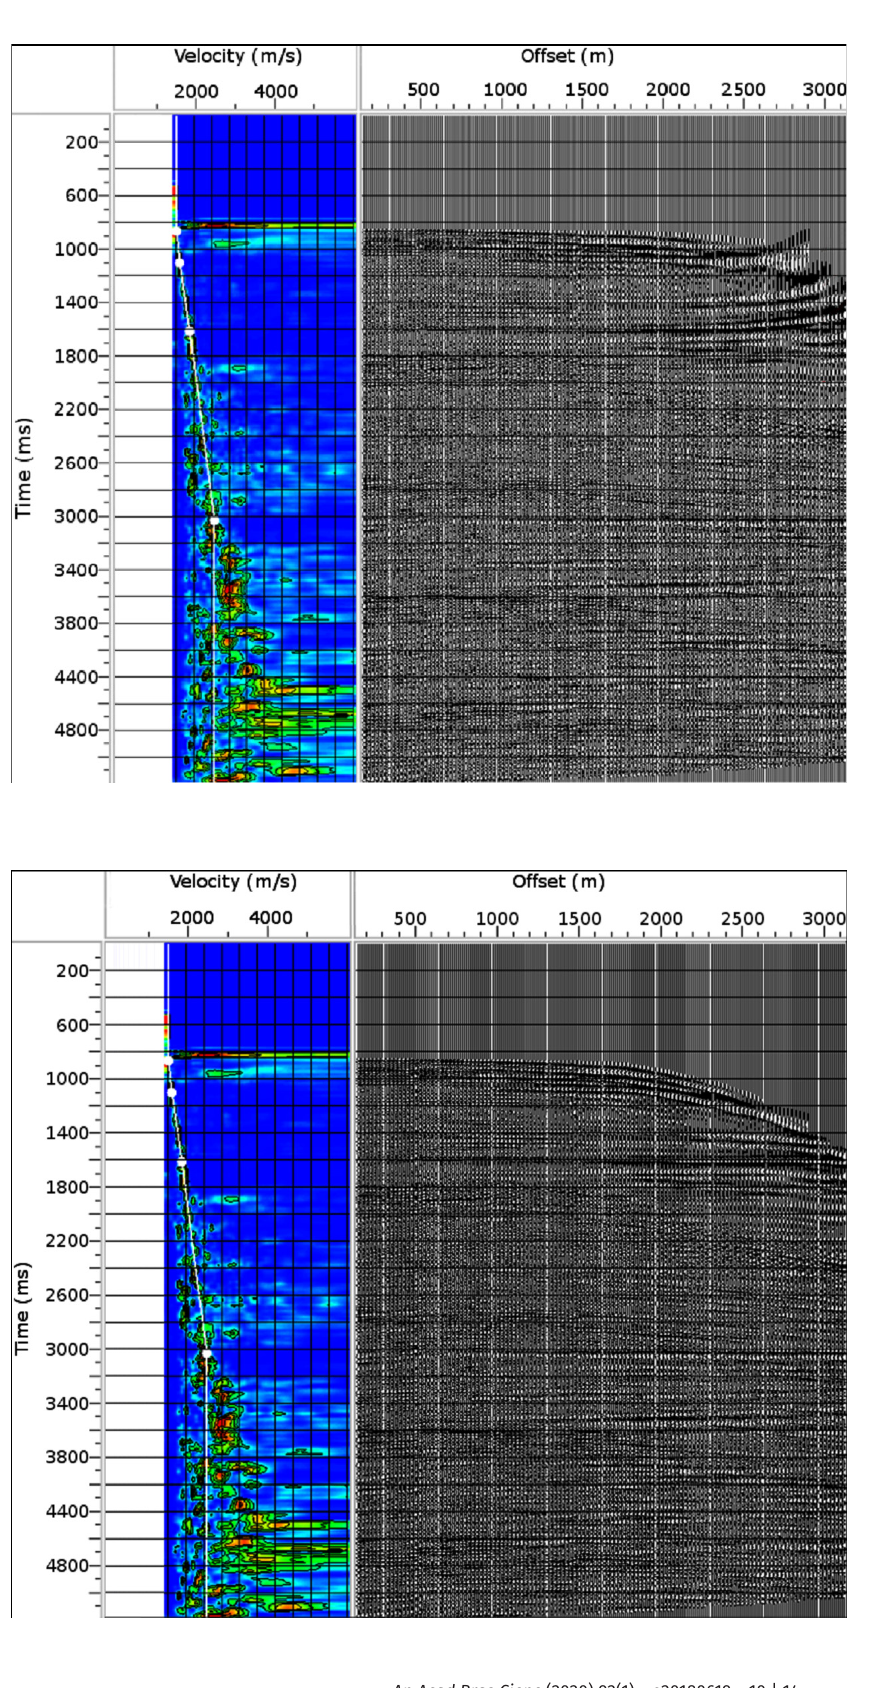
Figure 6. Velocity spectrum (left) and NMO correction (right) for the CMP gather 977. Estimated velocities (points on the white curve) were obtained through the hyperbolic approximation of the traveltime, equation (4).